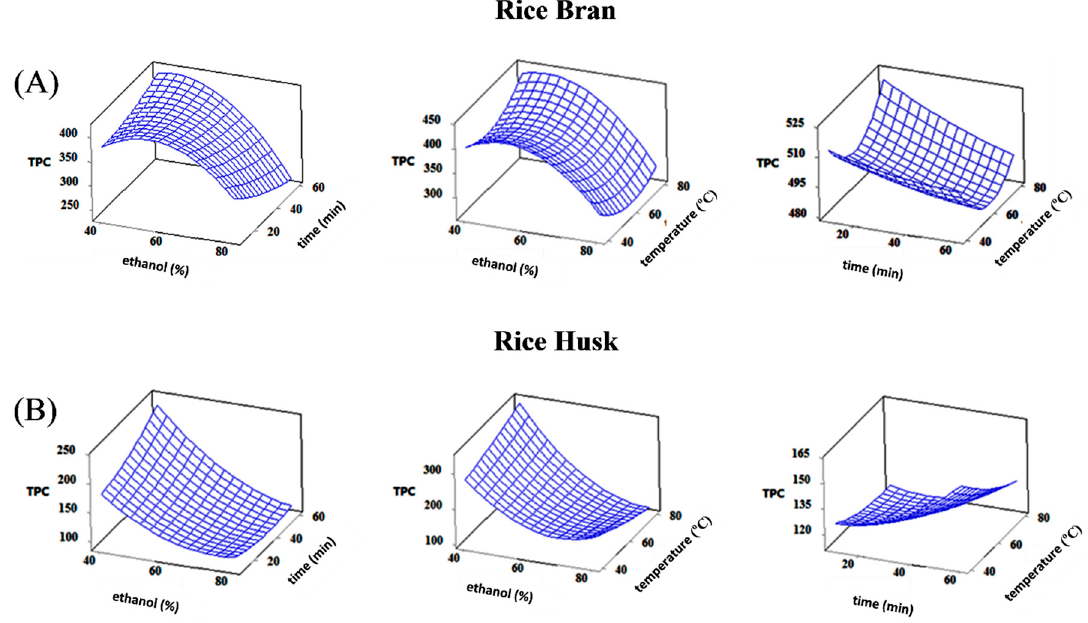
Figure 1. Effect of ethanol concentration, time and temperature extraction on total phenolic content (TPC, mg GAE/100 g) of free phenolics from ( A ) rice bran and ( B ) rice husk fractions.